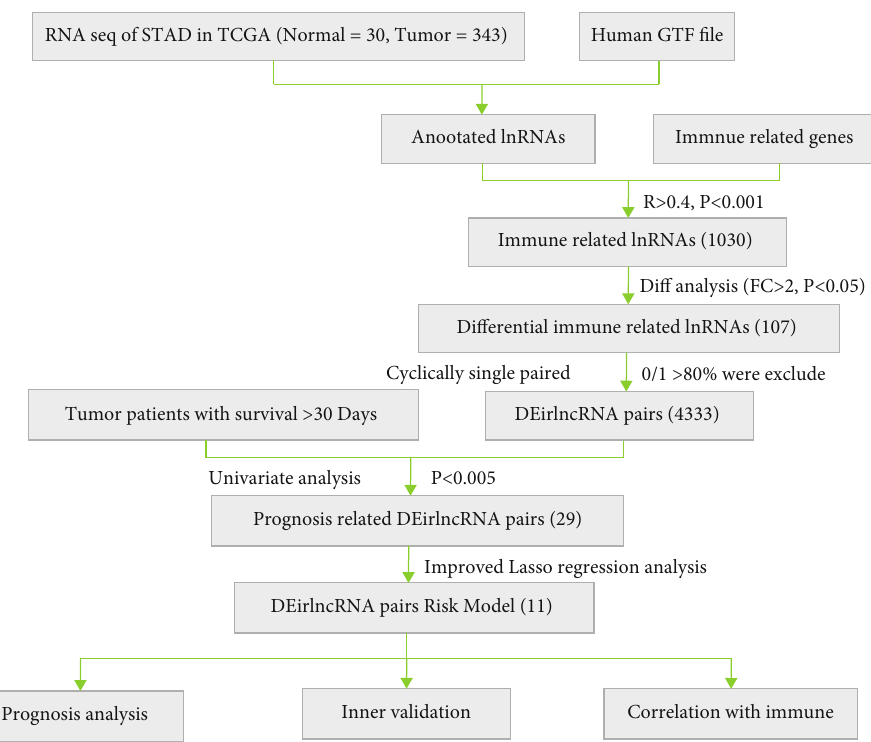
Figure 1: Work fl ow of this